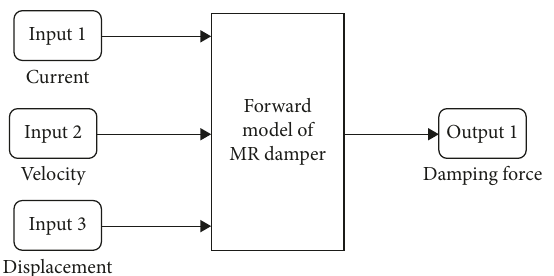
Figure 13: Forward model of MR dampers in SIMULINK.